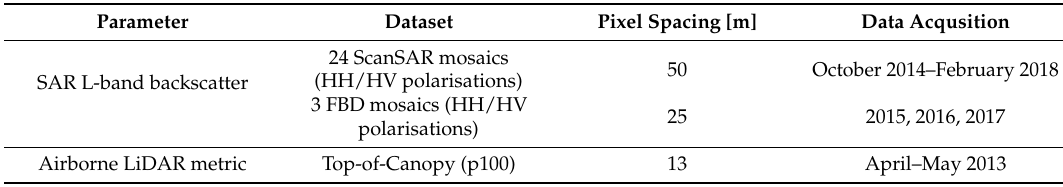
Table 1. Dataset used in the